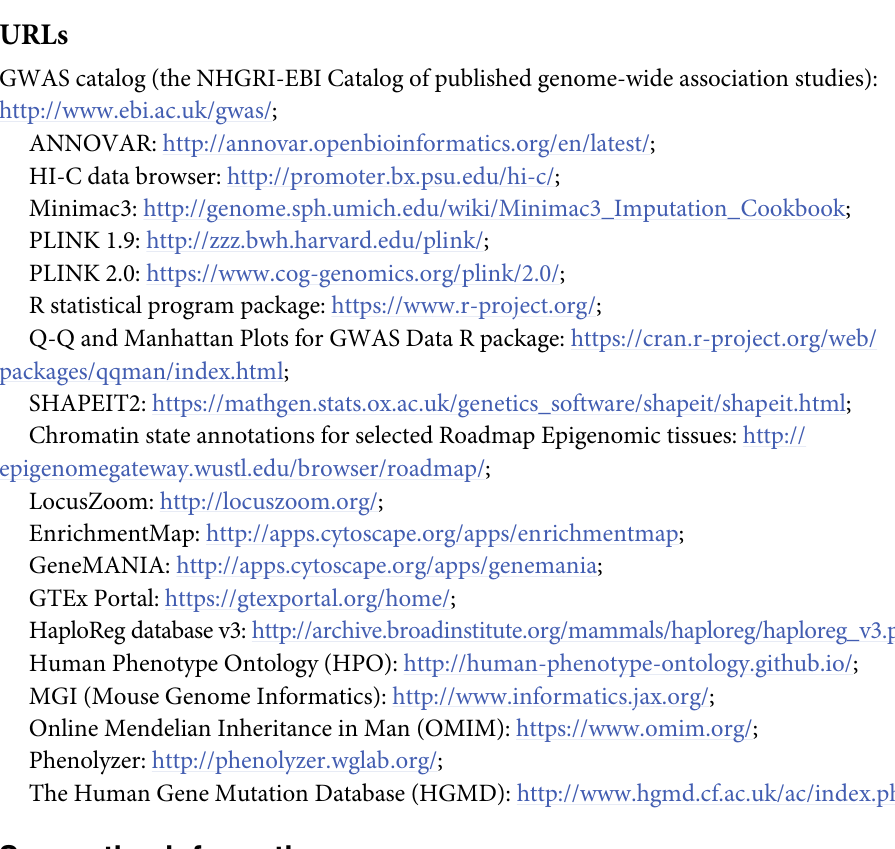
S3 Fig. Gross population stratification. Principal component analysis (PCA) for the GWAS samples: 930 CPO patients (BLACK), 945 CLO patients (RED) and 5,048 control individuals (GREEN). Although there are a bit structure among the controls in C2 vs. C3 and C2 vs.